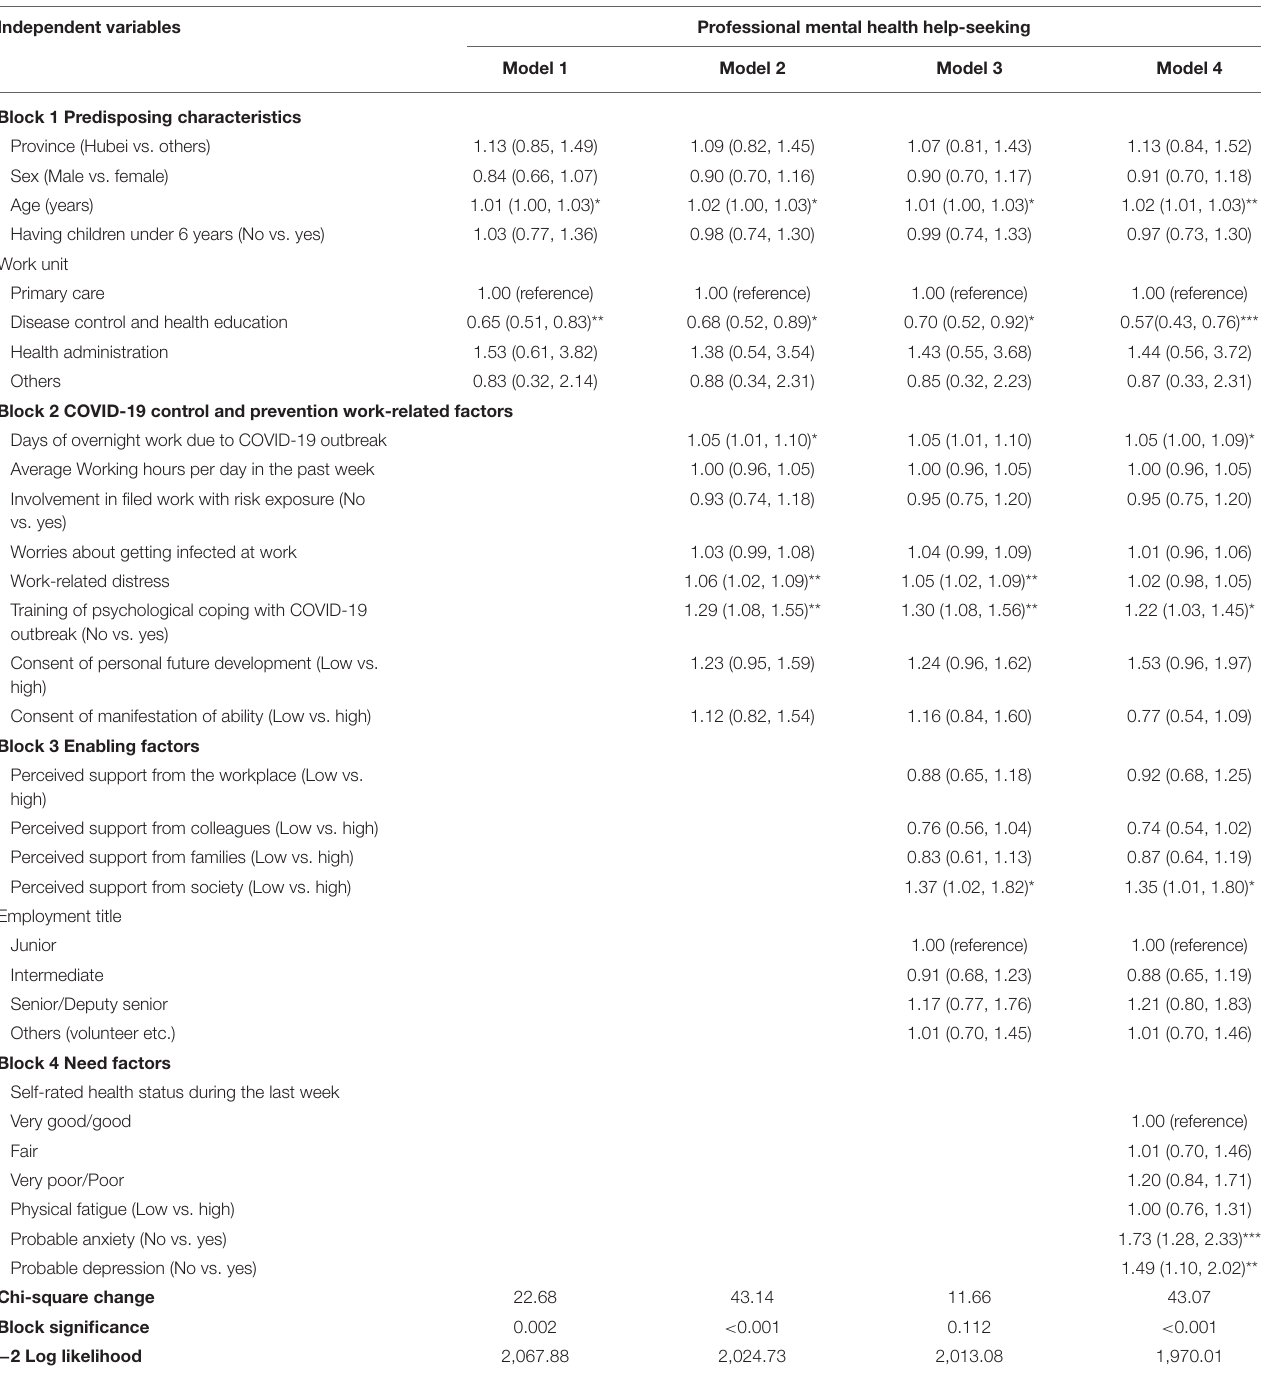
TABLE 3 | Results of hierarchical regression analyses of factors associated with mental health help-seeking among public health workers who reported probable mental health problems ( N = 3,417). Independent